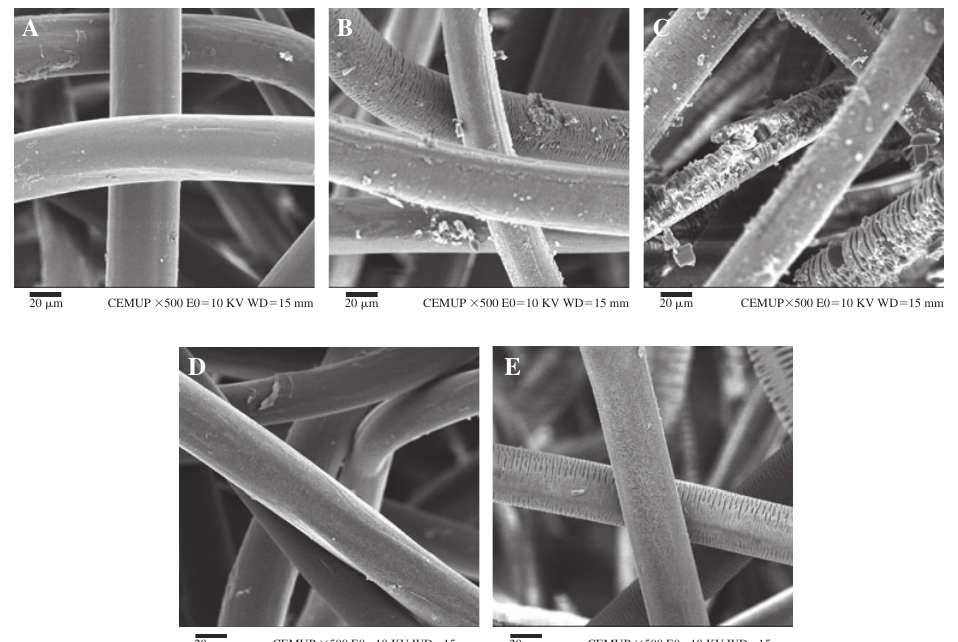
Figure 7 SEM photographs of the PP fi bers of the GTXs ( × 500): (A) unexposed fi bers; (B) GTX W2 after 500 h; (C) GTX W2 after 1000 h; (D) GTX W4 after 500 h; (E) GTX W4 after 1000 h.